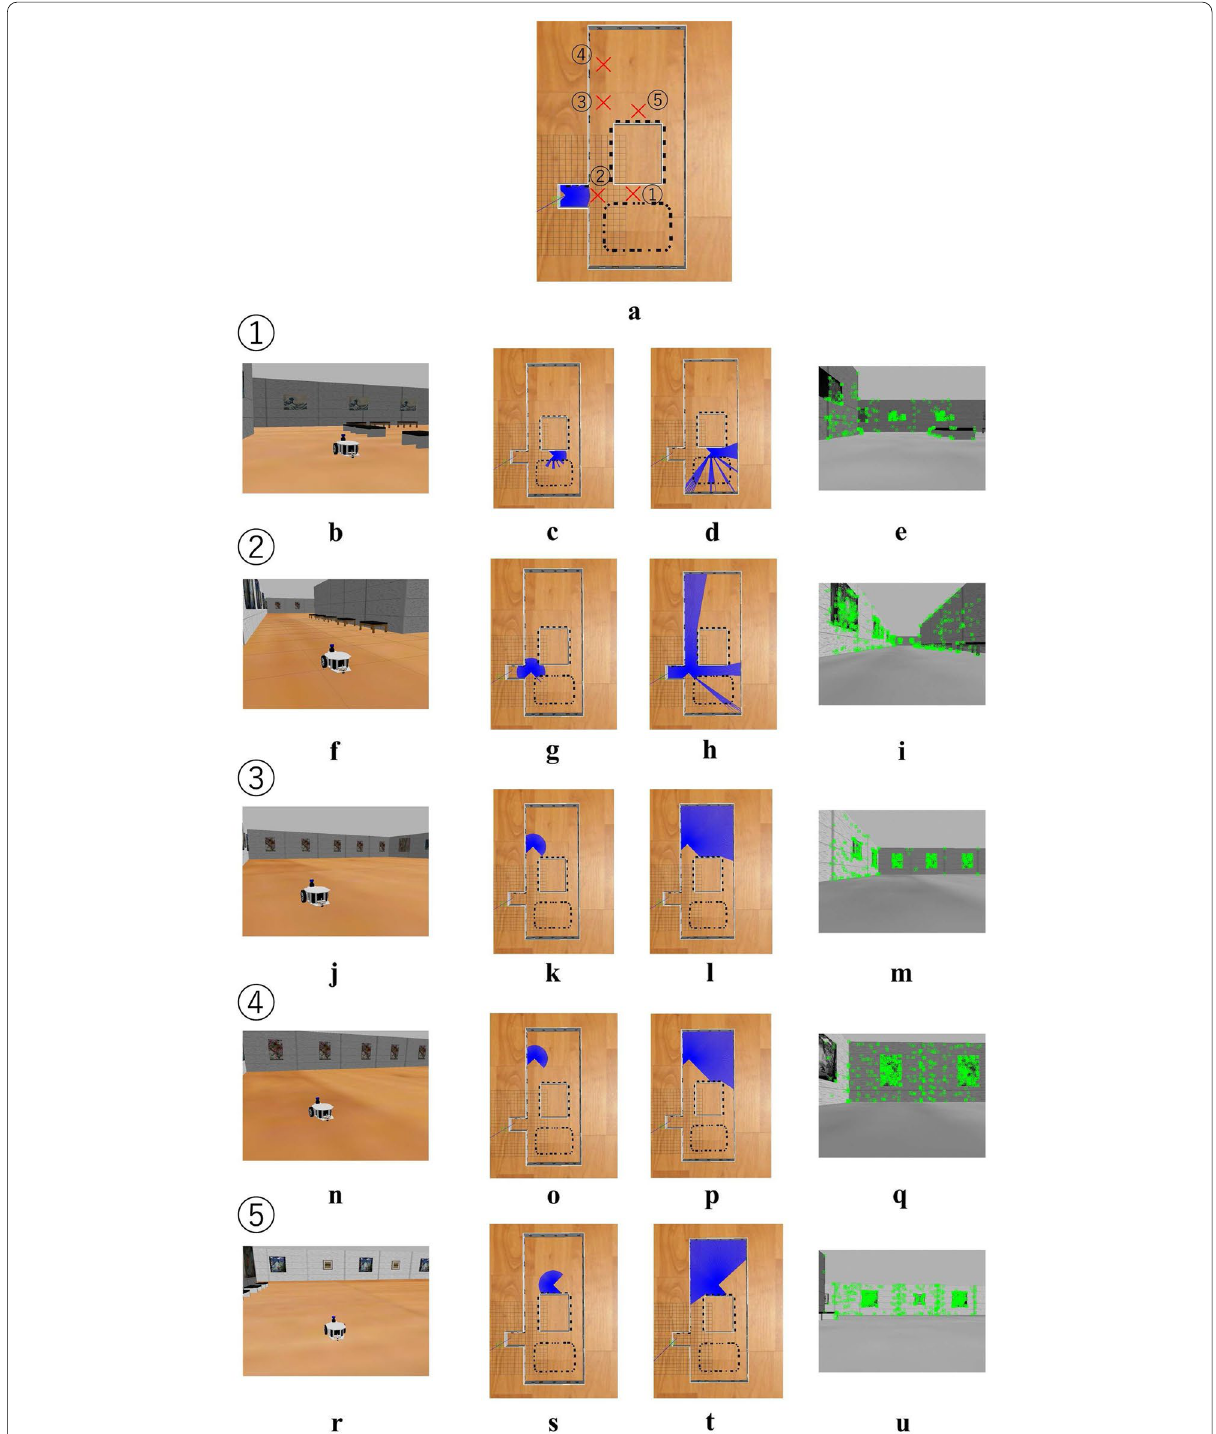
Fig. 9 Overall landscape and sensor information in specific position along the robot trajectory in simulation environment dealing with degeneracy in the direction of translation. a Selected position, b , f , j , n , r Overall landscape of the robot and the environment, c , g , k , o , s Laser scans of 4m Lidar, d , h , l , p , t Laser scans of 30m Lidar, e , i , m , q , u Images from monocular